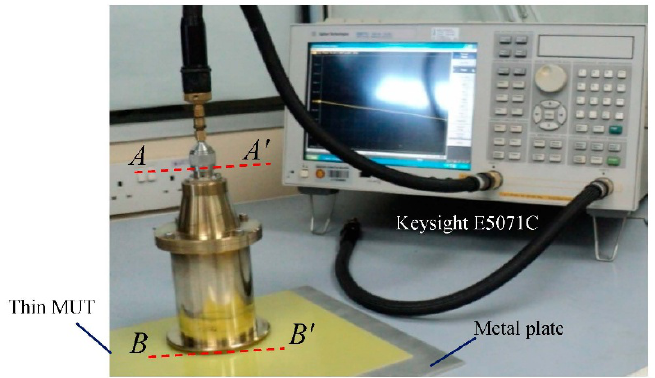
Figure 2. Experimental set-up and measurement.